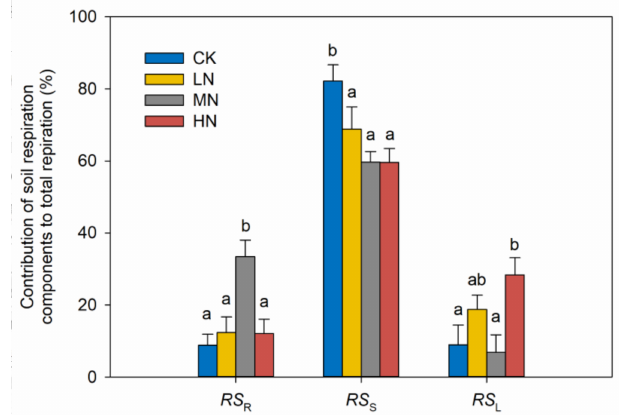
Figure 3. Mean values of the contribution of the soil respiration components to total respiration fluxes across five years. CK, LN, MN and HN represent control, low N, medium N and high N treatment, respectively. Different letters represent significant difference between N addition treatments ( p < 0.05).